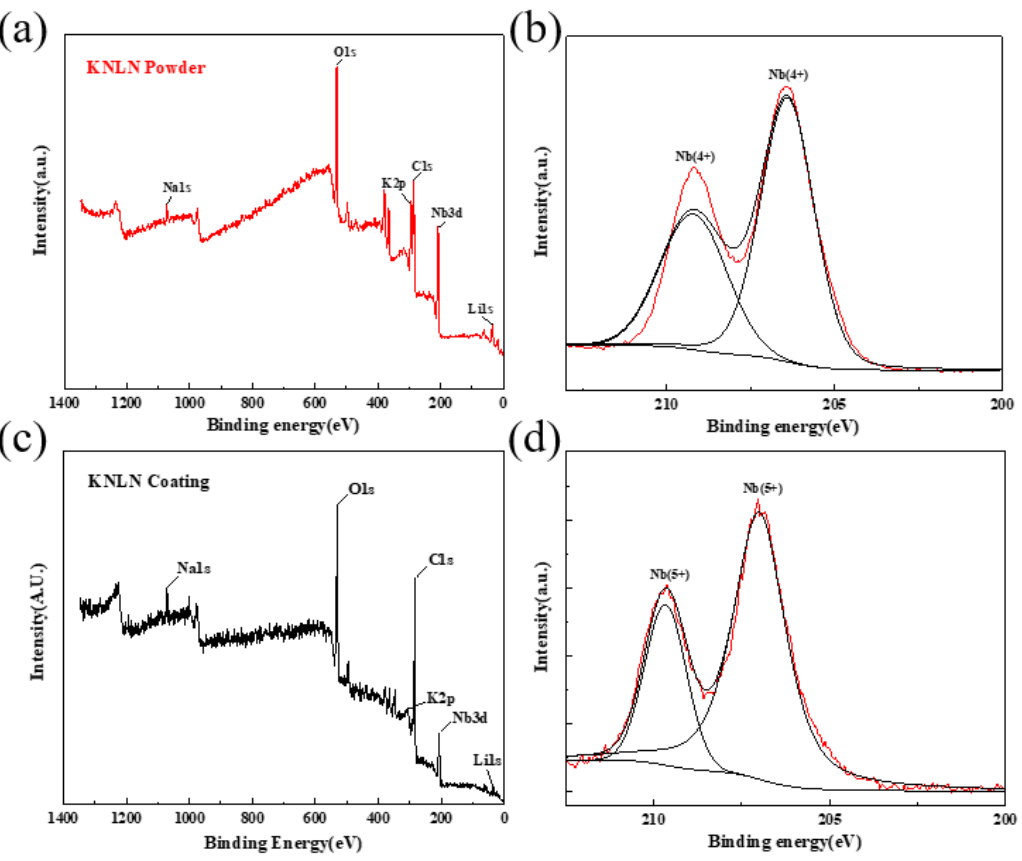
Figure 9. X-ray photoelectron spectroscopy (XPS) spectra of KNLN powders and coatings: ( a ) full spectrum of KNLN powder, ( b ) Nb element spectrum of KNLN powder, ( c ) full spectrum of KNLN coating, ( d ) Nb element spectrum of KNLN coating.